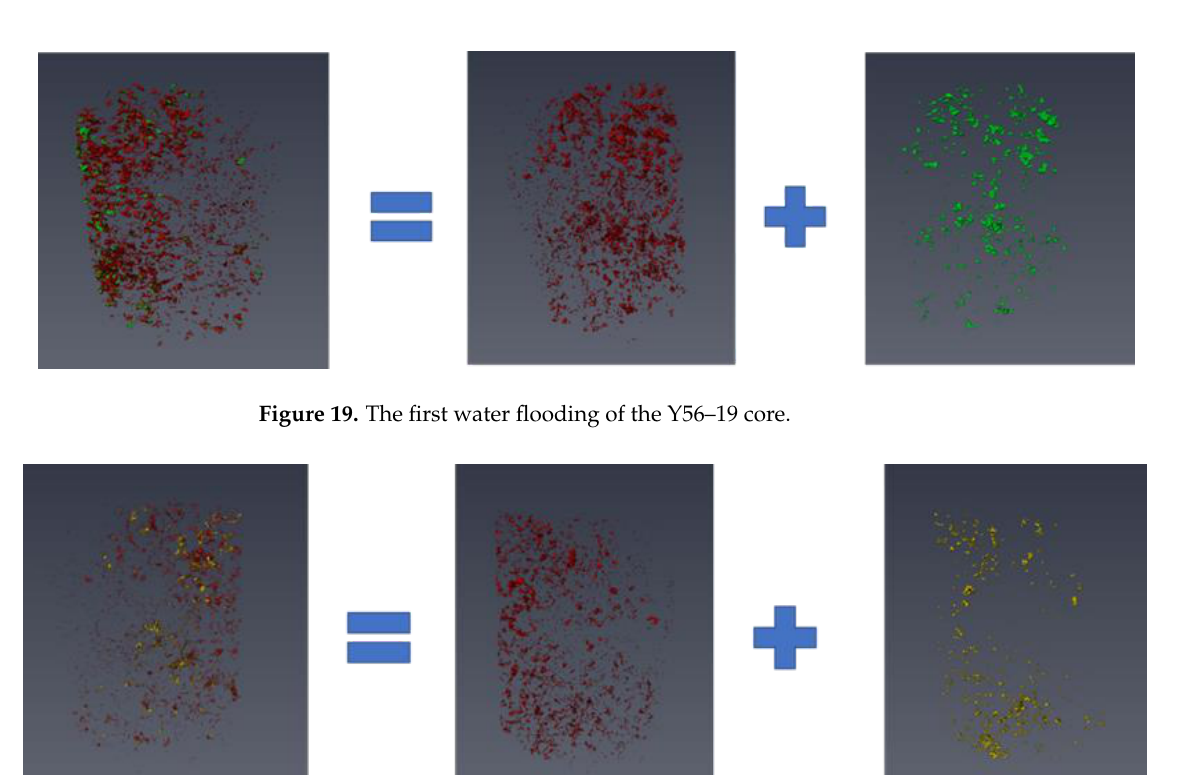
( e ) Figure 18. CT scanning results of the Y56 – 19 core under different displacement states. ( a ) Dry rock sample. ( b ) Saturated crude oil. ( c ) First water flooding. ( d ) CO 2 flooding. ( e ) Second water flood- ing. (1) The first water flooding: a certain amount of crude oil in the pores was produced by water flooding, and the capillary force played a major role in water flooding, but there were still a lot of crude oil residue in the pore space. The micro-oil displacement mecha- nism was mainly of the stuck or crawling type. The existence of irreducible water pro- moted the occurrence of the stuck state and improved the saturation of the residual oil. The residual oil was mainly in thin films and as continuous oil (Figure 19).